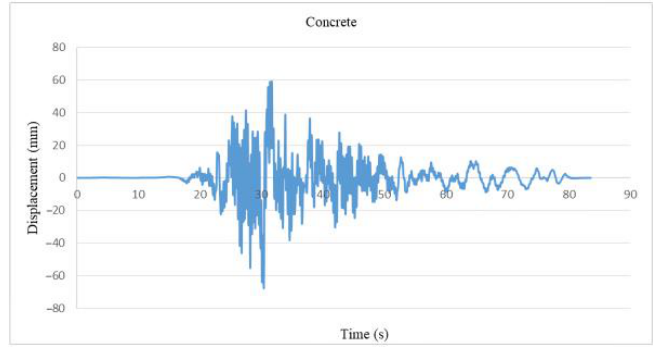
Figure 20. Time-displacement curve for minaret made of C25 concrete.